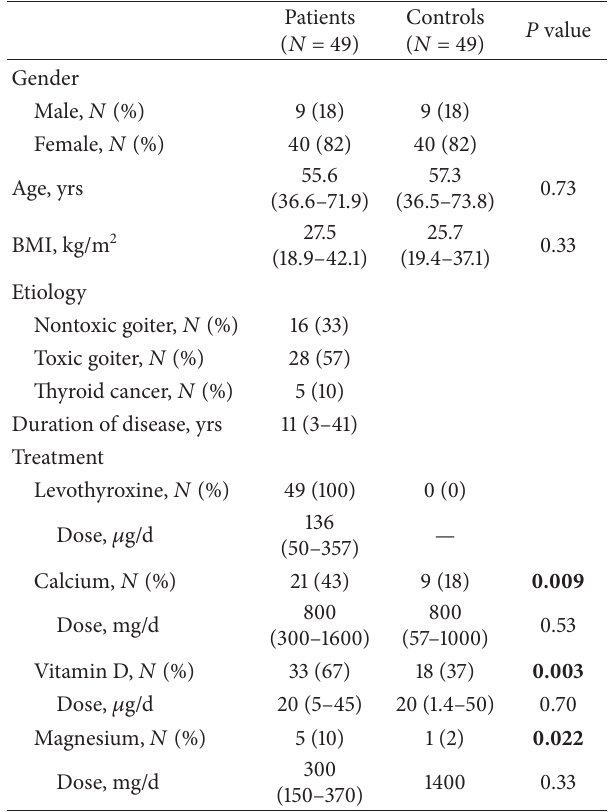
Table 1: Baseline characteristics of all included patients on long- term treatment with levothyroxine and matched controls. Number of subjects ( 𝑁 ) with percentages within group (%) or median with range